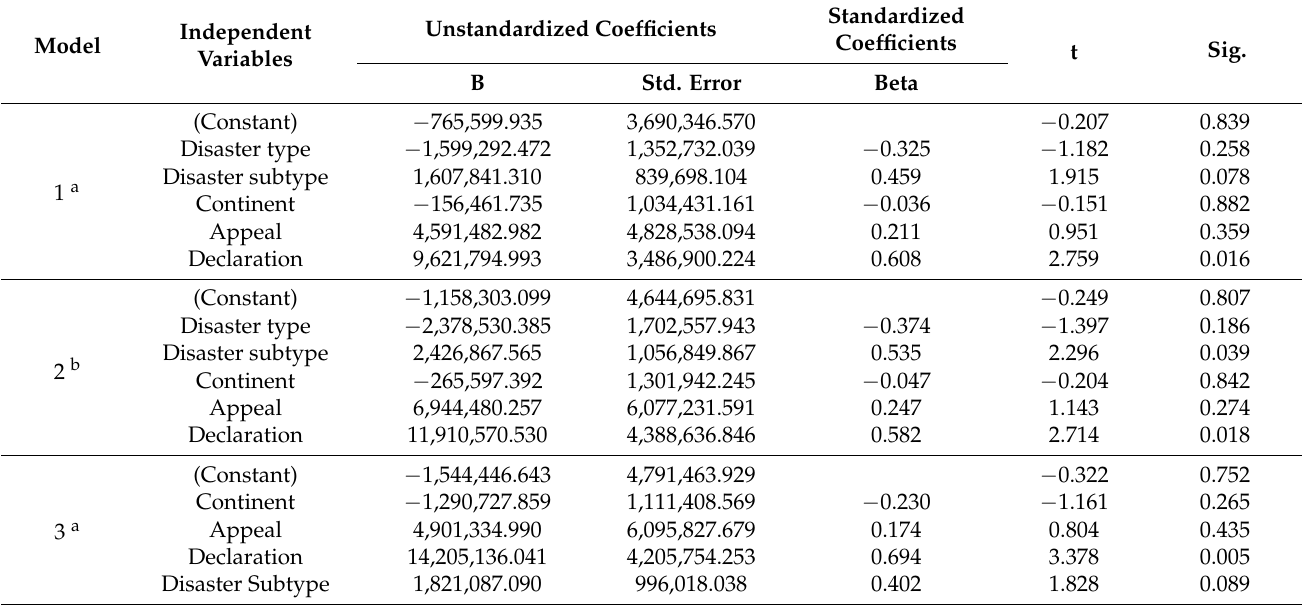
Table 10. The regression coefficients for each